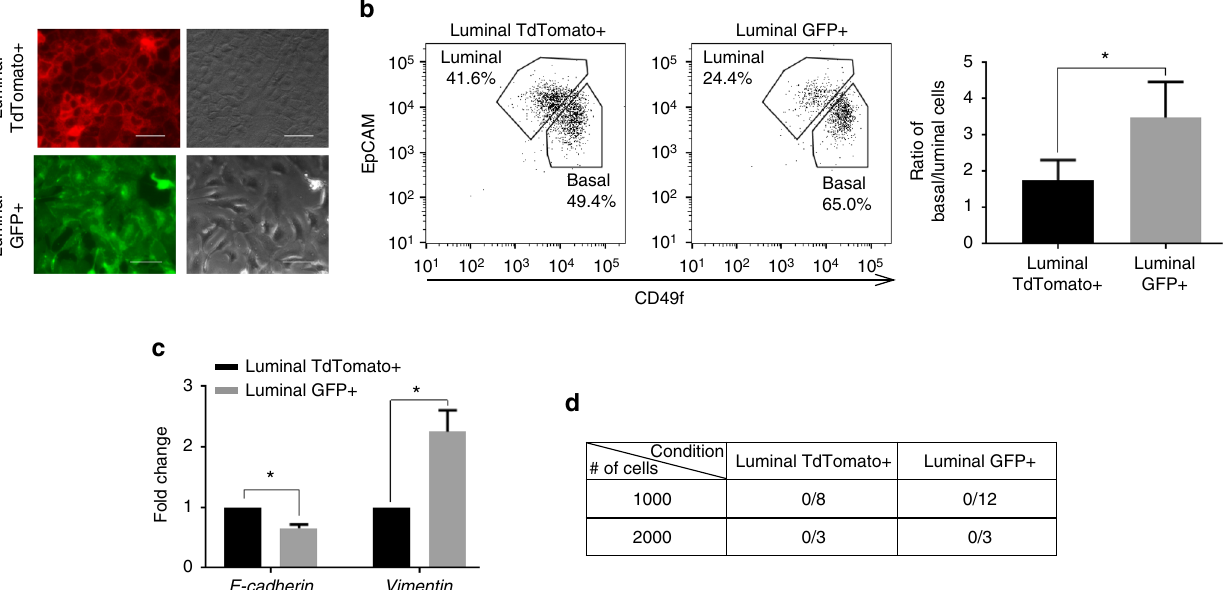
Fig. 3 Luminal S100a4 traced cells acquire mesenchymal features but cannot transplant in vivo. a TdTomato+ and GFP+ luminal cells were sorted from 10 – 12-week-nulliparous females and plated in 2D culture. TdTomato+ cells show distinct cuboidal morphology (top) while the GFP+ S100a4 lineage traced cells are more mesenchymal like (bottom). Scale bar, 50 µ m. b FACS analysis of TdTomato+ (left) and GFP+ (middle) luminal cells grown in 3D culture. TdTomato+ luminal cells are plated in 3D culture where some cells switch to GFP+. The organoids are then dissociated and analyzed based on EpCAM/ CD49f. Ratio of basal to luminal cells calculated from 3D culture ( n = 3 cultures derived from three mice, * p < 0.05, paired t -test). c Real time expression analysis of luminal GFP+ compared to TdTomato+ cells isolated from 3D culture. Gene expression values were normalized to Gapdh . ( n = 2 biological replicates). The data are shown as mean ± SD. * p < 0.05, t -test). d Luminal TdTomato+ and GFP+ cells were sorted from 10 – 12-week-nulliparous females and transplanted in 3-week old mice. Also see Supplementary Fig. 2a. Transplant data are combined from two independent transplant were double positive (DP) (i.e., Keratin-14 TdTomato+/S100a4- GFP+) consisting of luminal and basal cells (Fig. 1b, top right panel). This data showed that a small population of lineage traced